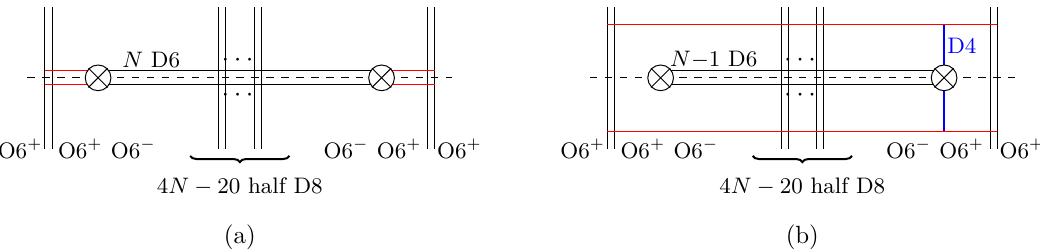
Figure 2. Inclusion of codimension 2 defect. In (a), half D8-branes are moved across half NS5- branes which leads to brane creation, which is indicated by the red segments. In (b), a Higgs branch direction opens up by aligning the created D6-branes with a gauge D6-brane. If an additional D4- brane is suspended between the red D6-brane, moving along the Higgs branch direction, and the residual brane configuration, then a codimension 2 defect is present for the SO(2 N − 2)